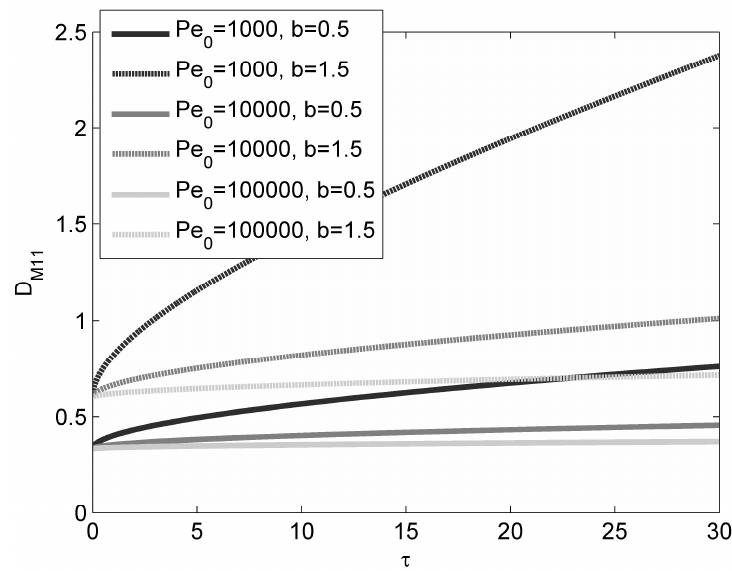
Figure 1. Longitudinal macro-dispersion coefficient for variable Péclet numbers and scaling exponents.